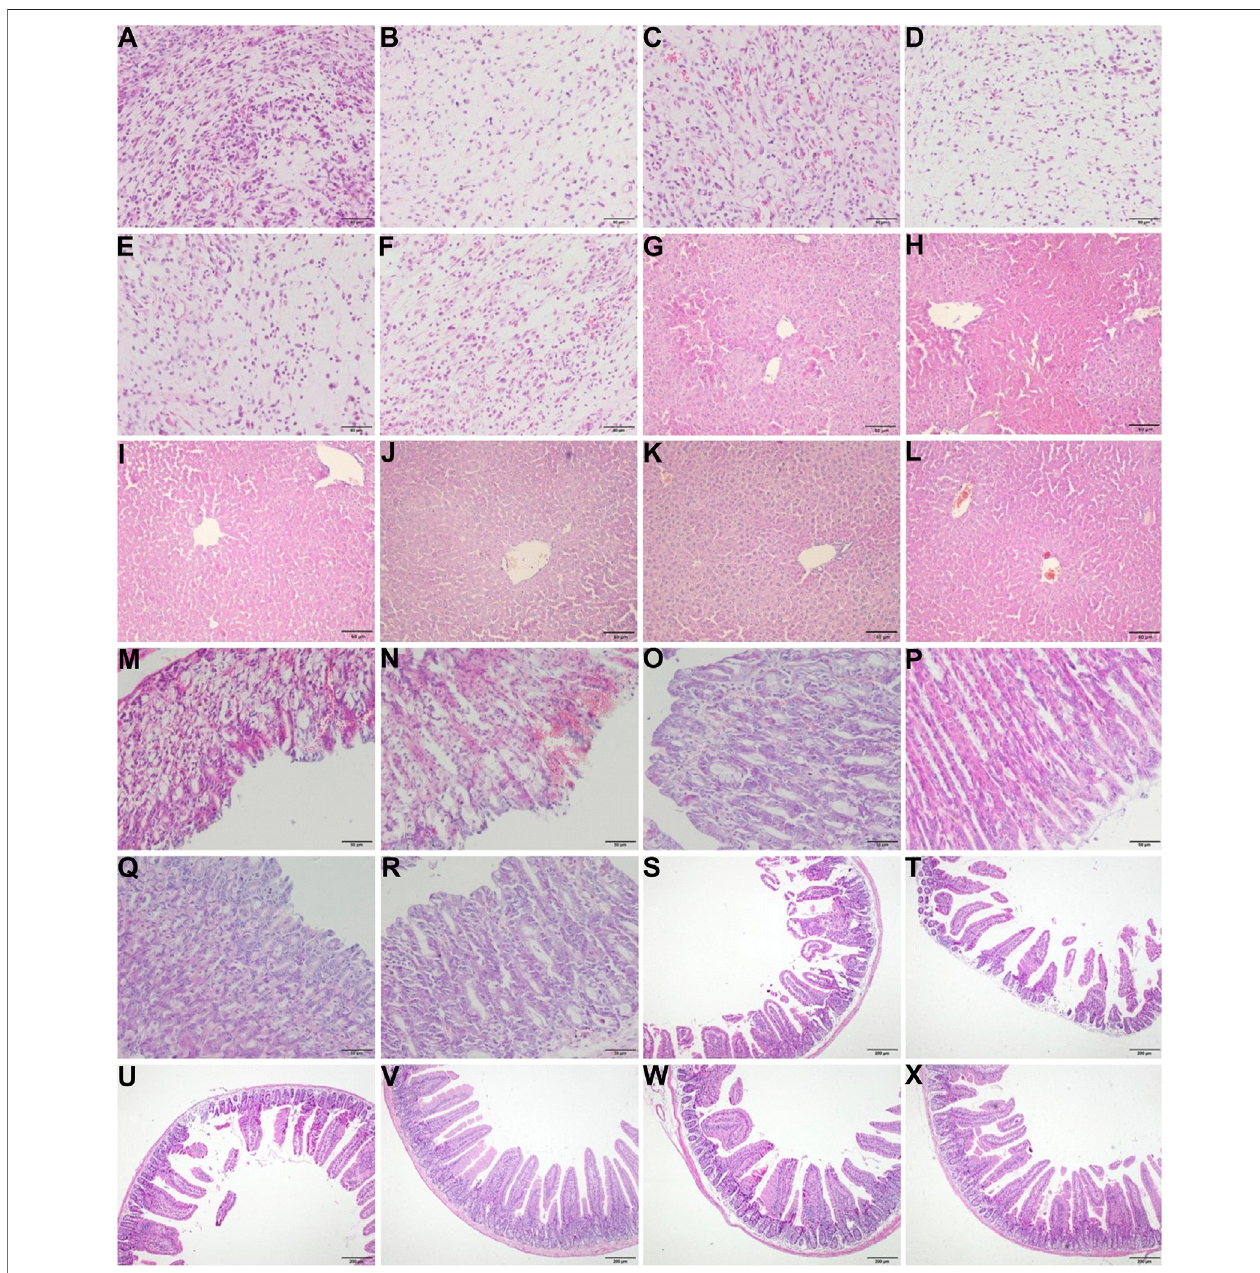
FIGURE 3 | Effects of CHB-II-F on pathology of tumor, liver, gastric, and duodenal tissues in the transplanted H 22 hepatocellular carcinoma model mice receiving chemotherapy. Sections werestained with hematoxylin and eosin (Hand E)and viewedat a magni fi cation of × 400 [for tumor (A – F) and gastric tissue (M – R) ], × 200[for liver tissue (G – L) ], or × 100 [for duodenal tissue (S – X) ; (A) (G) (M) (S) . Model (saline/negative control); (B) (H) (N) (T) . 5-FU-treated control (20 mg/kg); (C) (I) (O) (U) . YangzhengXiaojicapsule-treatedcontrol(0.78 g/kg); (D)(J)(P)(V) .CHB-II-F(65 g/kg); (E)(K)(Q)(W) .CHB-II-F(32.5 g/kg); (F)(L)(R)(X) .CHB-II-F(16.25 g/kg). Scale bar, 50 μ m for (A – R) and 200 μ m for (S – X)